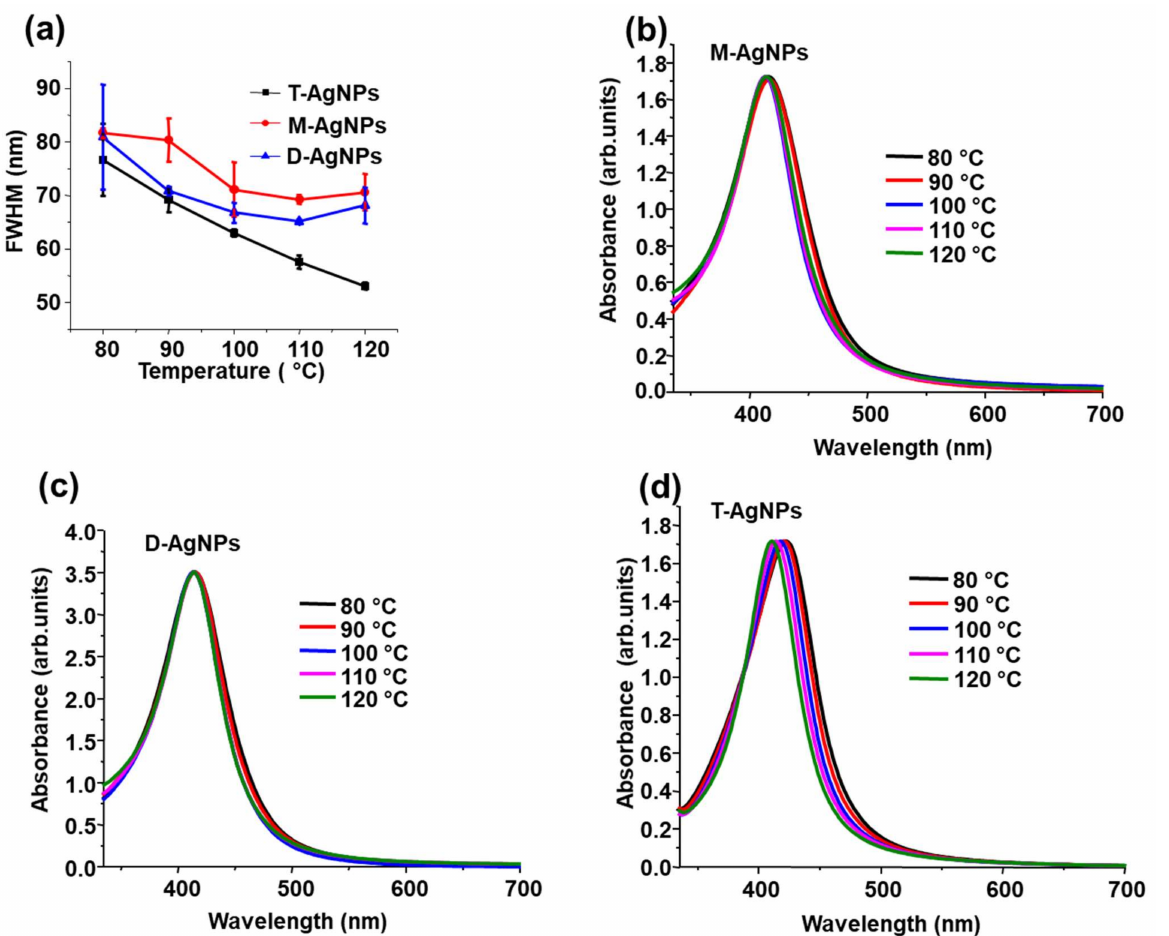
Figure 3. ( a ) FWHM (average of two sets of values from different batches of particles) of M-AgNPs, D-AgNPs, and T-AgNPs. UV-Vis spectra of: ( b ) M-AgNPs; ( c ) D-AgNPs; ( d )